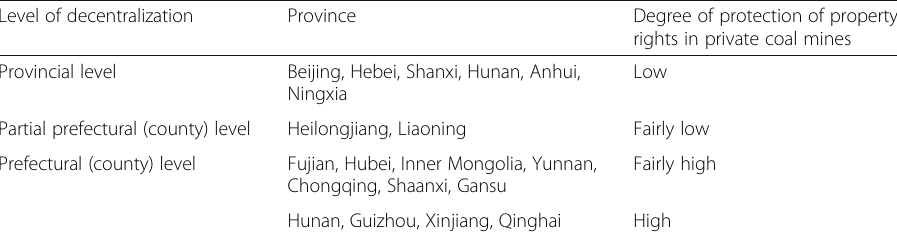
Table 6 Correlation between the level of decentralization and the degree of property rights